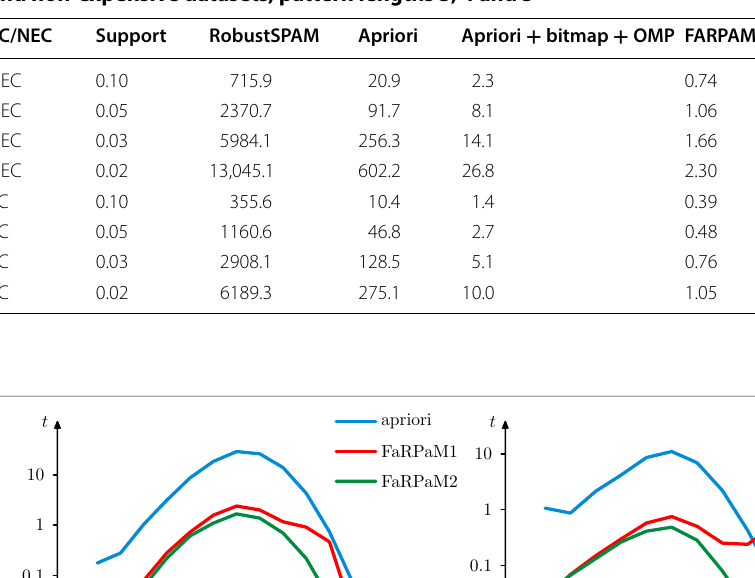
Table 5 Run times (in seconds) for algorithms with uncertainty β = 60 for expensive and non-expensive datasets, pattern lengths 3, 4 and 5